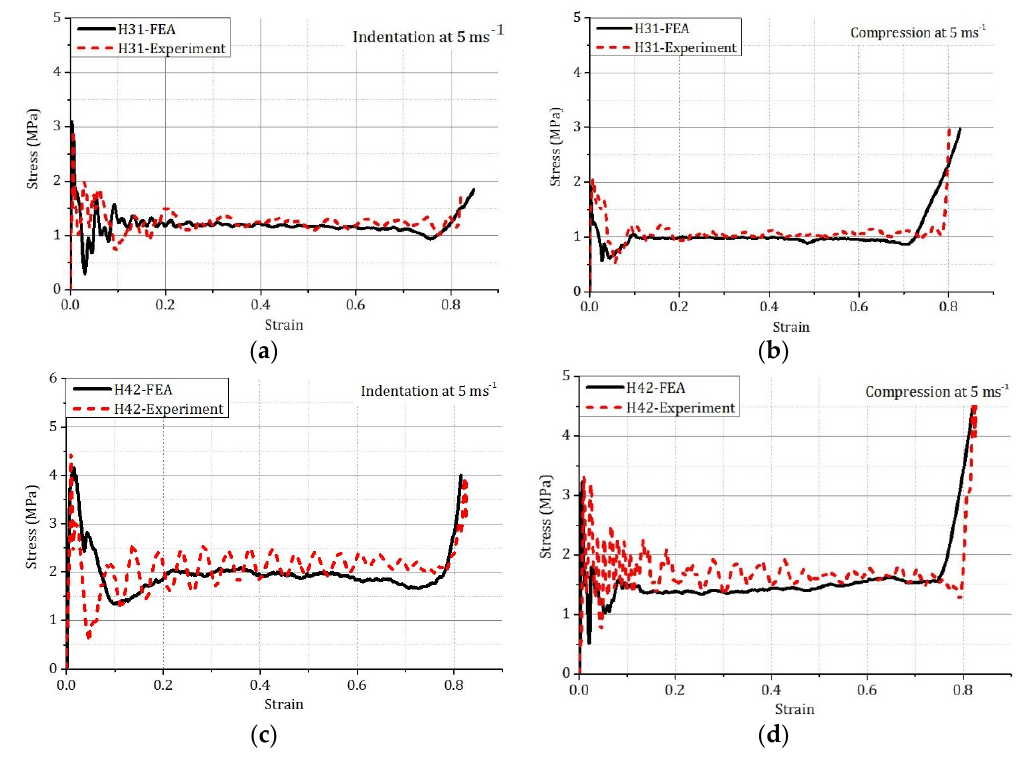
Figure 4. Experimental and FEA stress–strain curves of two types of honeycombs at 5 ms − 1 : ( a ) indentation of H31; ( b ) compression of H31; ( c ) indentation of H42; ( d ) compression of H42.